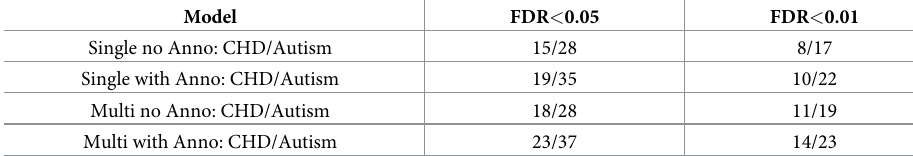
Table 1. Results for M-DATA single-trait and multi-trait models.